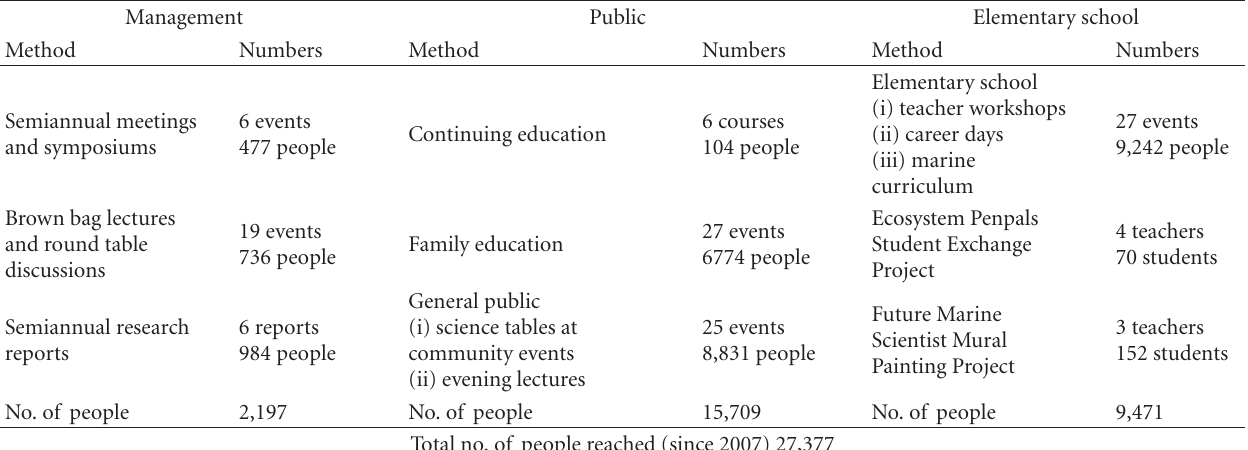
Figure 1: HIMB NWHI research partnership semiannual report sections read. (Survey participants had the option of selecting more than one section with the exception of those who selected all sections.) Table 2: The NWHI-RP communications methods since 2007 for management, public, and elementary school